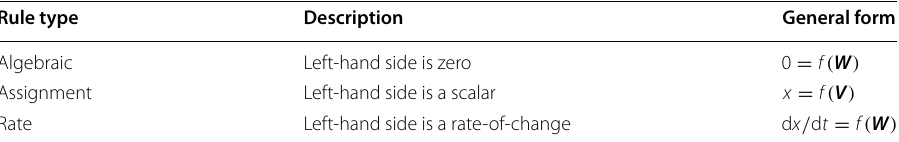
Table 1 The three kind SBML